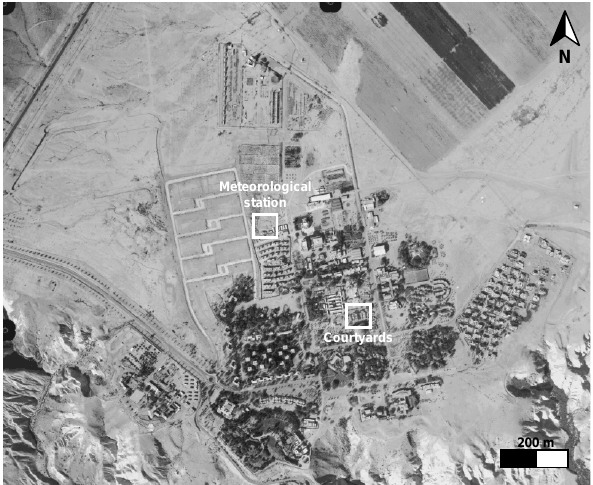
Fig. 3. Aerial photograph of the Sde-Boqer experimental site. The location of the instrumented courtyards and the meteorological sta- tion is pointed out by the two white frames.